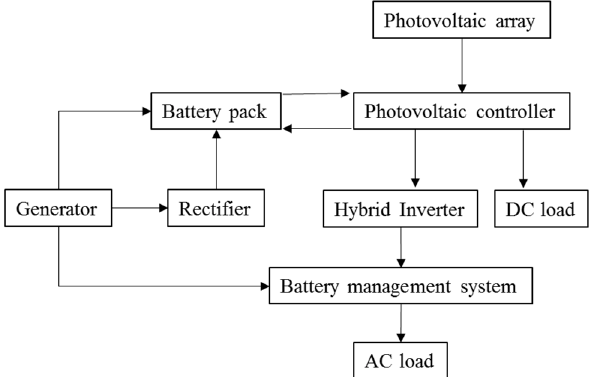
Figure 4. Schematic representation of a hybrid system and key components.